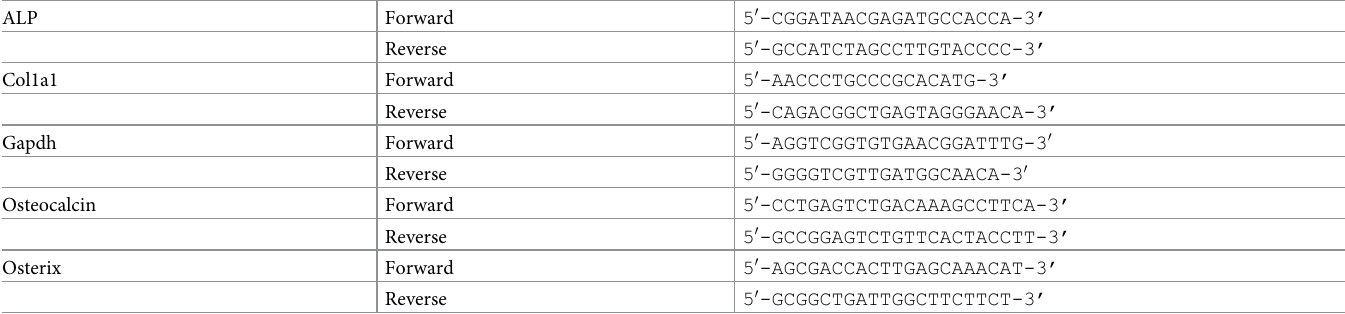
Table 1. Sequences of primers for qRT-PCR.